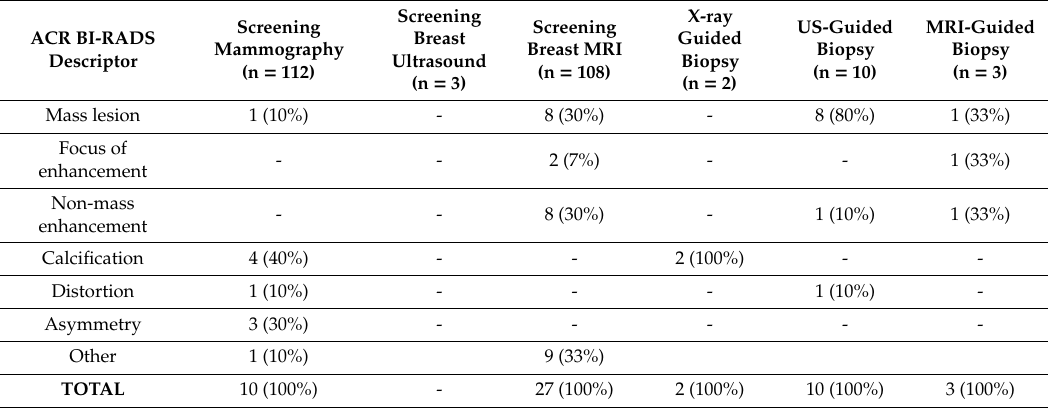
Table 1. Summary of the imaging actionable findings distributed by modality in women diagnosed with NF1 seen at the ERNC between